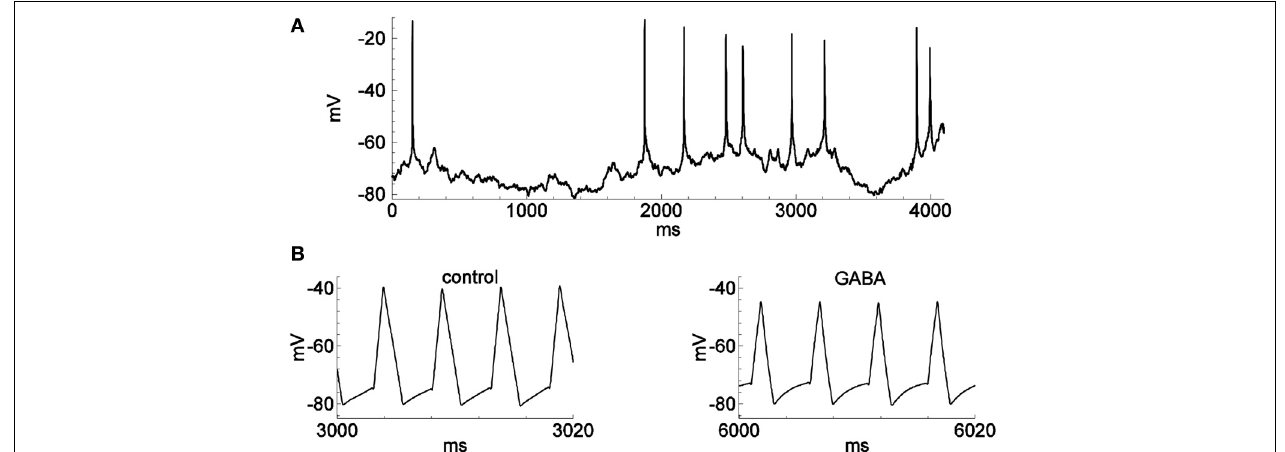
hyperpolarizing stimulation by a constant injected current of − 30pA. (B) Voltage trace (note expanded time scale) with probe spikes before (left) and during GABA application (1.0mM;